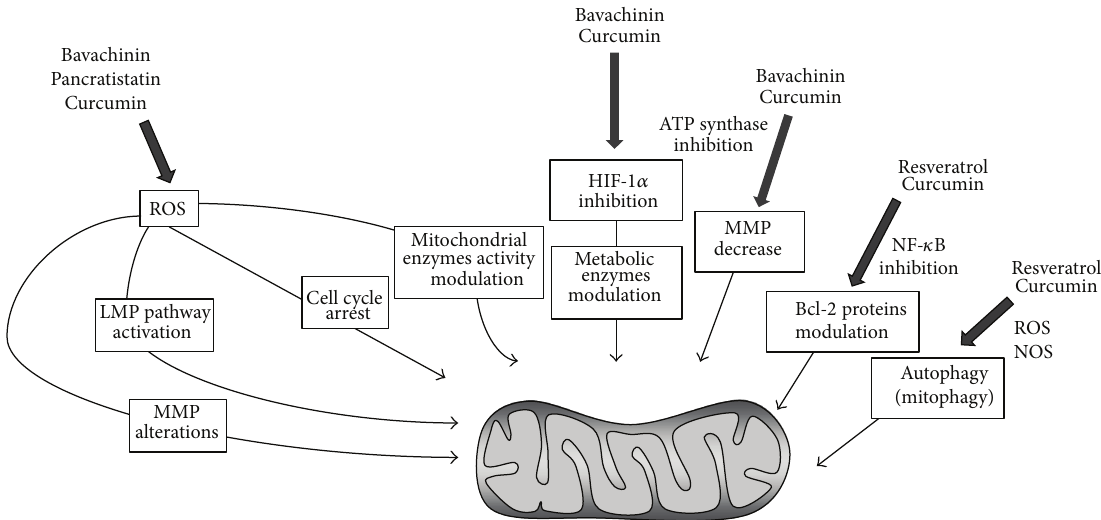
Figure 2: Mitochondrial dysfunctions as pharmacological targets. Examples of natural compounds with a potential efficacy in cancer treatment. The figure schematizes their mechanism of action linked to mitochondrial dysfunctions. The compounds discussed herein have different mitochondrial targets, such as mitochondrial membrane potential (MMP), Bcl-2 family proteins (Bcl-2), reactive oxygen species (ROS), HIF-1 𝛼 , mitochondrial metabolism (MM), and